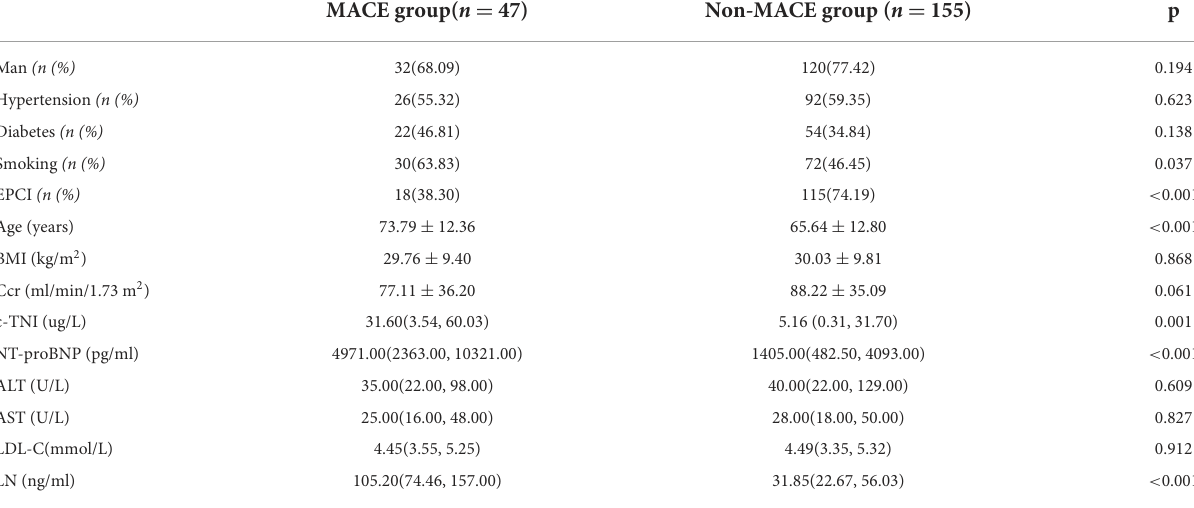
TABLE 1 Comparison of baseline data between two groups.